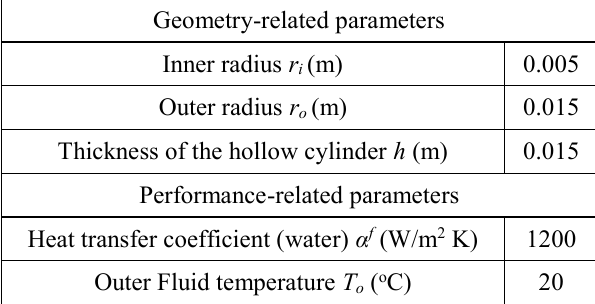
Table 2 . Geometry- and performance-related